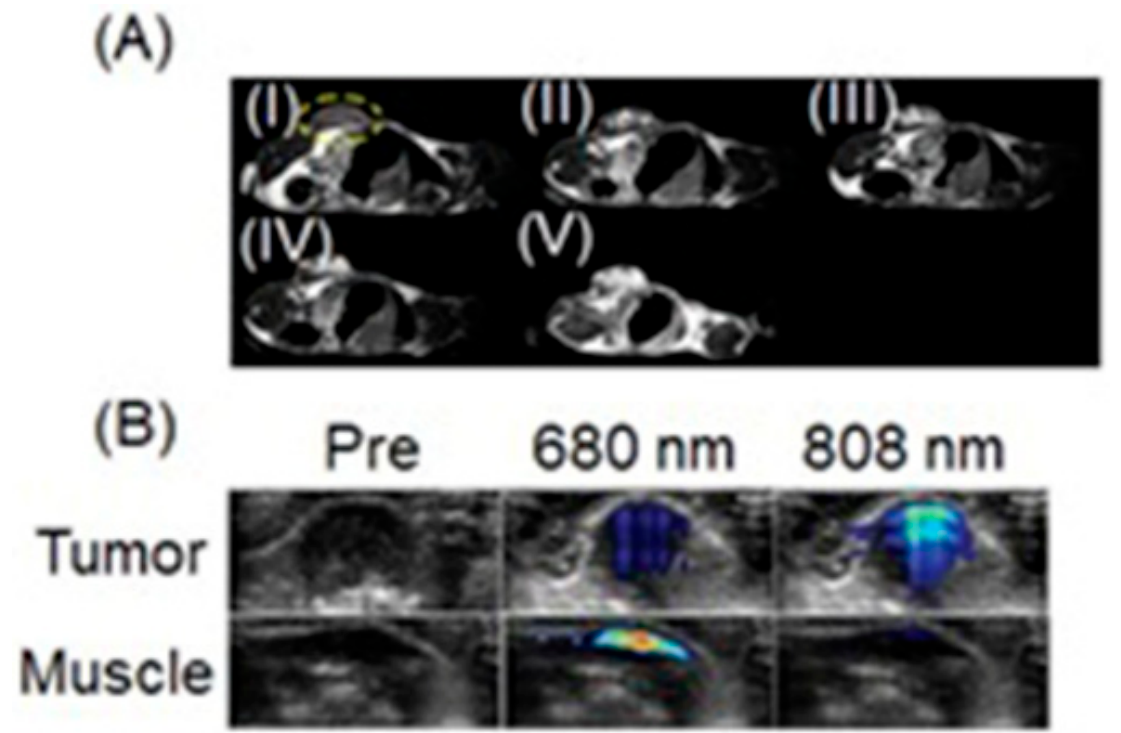
Figure 59. ( A ) Coronal MRI images of an EMT-6 tumor-bearing mouse before and after multi-site injection of the complex (16 mM Fe). The tumor site is indicated by yellow dashed circle in each image. Injected volumes are (I) 0, (II) 25, (III) 50, (IV) 75, and (V) 100 µ L. ( B ) Photoacoustic imaging of a mouse with an EMT-6 tumor (upper panels) or muscle (bottom panels) injected with the Fe III - containing complex and under pulse laser irradiation at different wavelengths. Adapted with per-